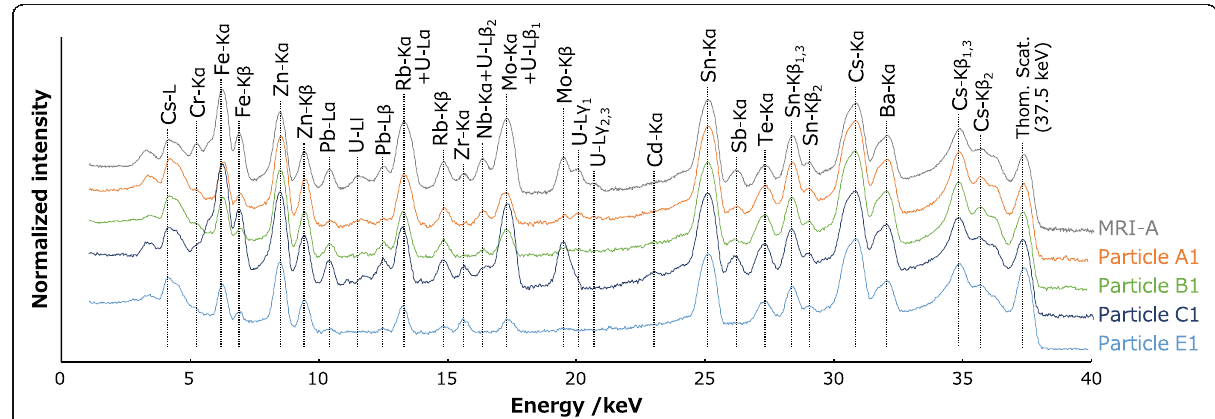
Fig. 3 SR- μ -XRF spectra of four representative CsMPs (A1, B1, C1, and E1) isolated from the SPM filter-tape samples, showing the heavy elemental composition of individual particles. The intensity of each spectrum is displayed on a logarithmic scale and shifted in a longitudinal direction. The spectrum of MRI-A shows datum obtained for one of type A CsMPs (particle A) collected at the MRI in the previous study (Abe et al.